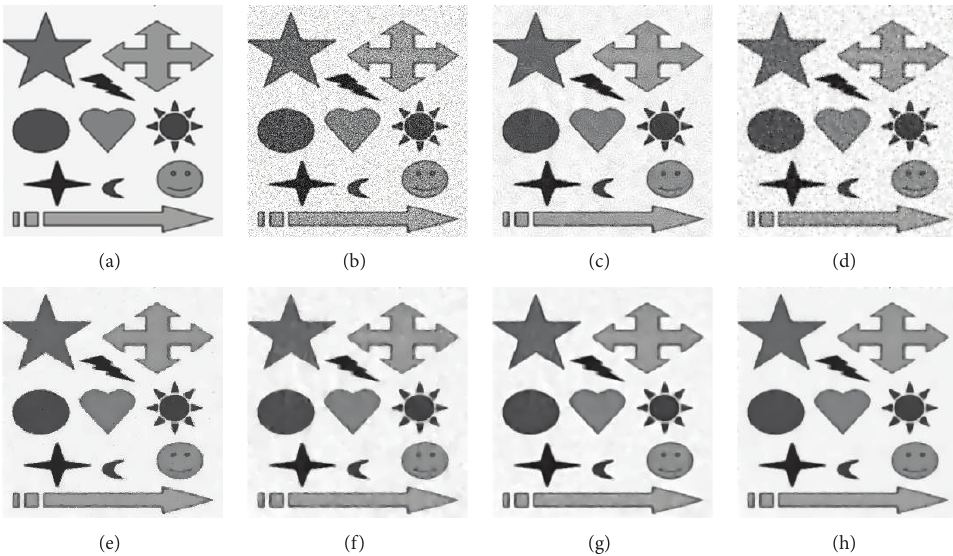
Figure 1: Result of the synthetic image by the five models: (a) original image, (b) noisy image, (c) result by NLM, (d) result by Y-K model, (e) result by PM, (f) result by TV, (g) result by MTV, and (h) result by our model.